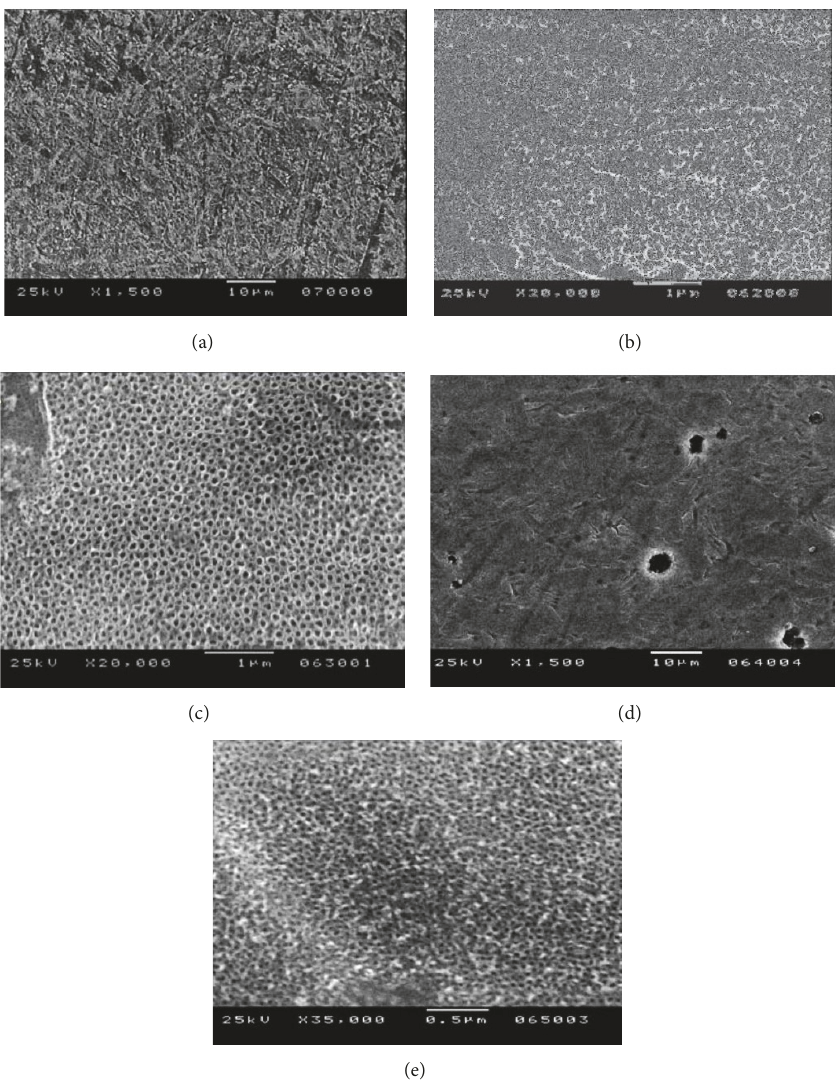
Figure 4: SEM images of titanium oxides that are anodically prepared under different anodizing conditions: (a) chemical etch in 0.5wt% HF for 30s, (b) aqueous 0.3wt% HF + 1 M H 3 PO 4 at 20 V, (c) aqueous 0.5wt% HF + 1M H 3 PO 4 at 20 V, (d) aqueous 0.5wt% HF + 1 M H 3 PO 4 at 10 V, and (e) aqueous 0.5wt% HF + 1M H 3 PO 4 at 150 V